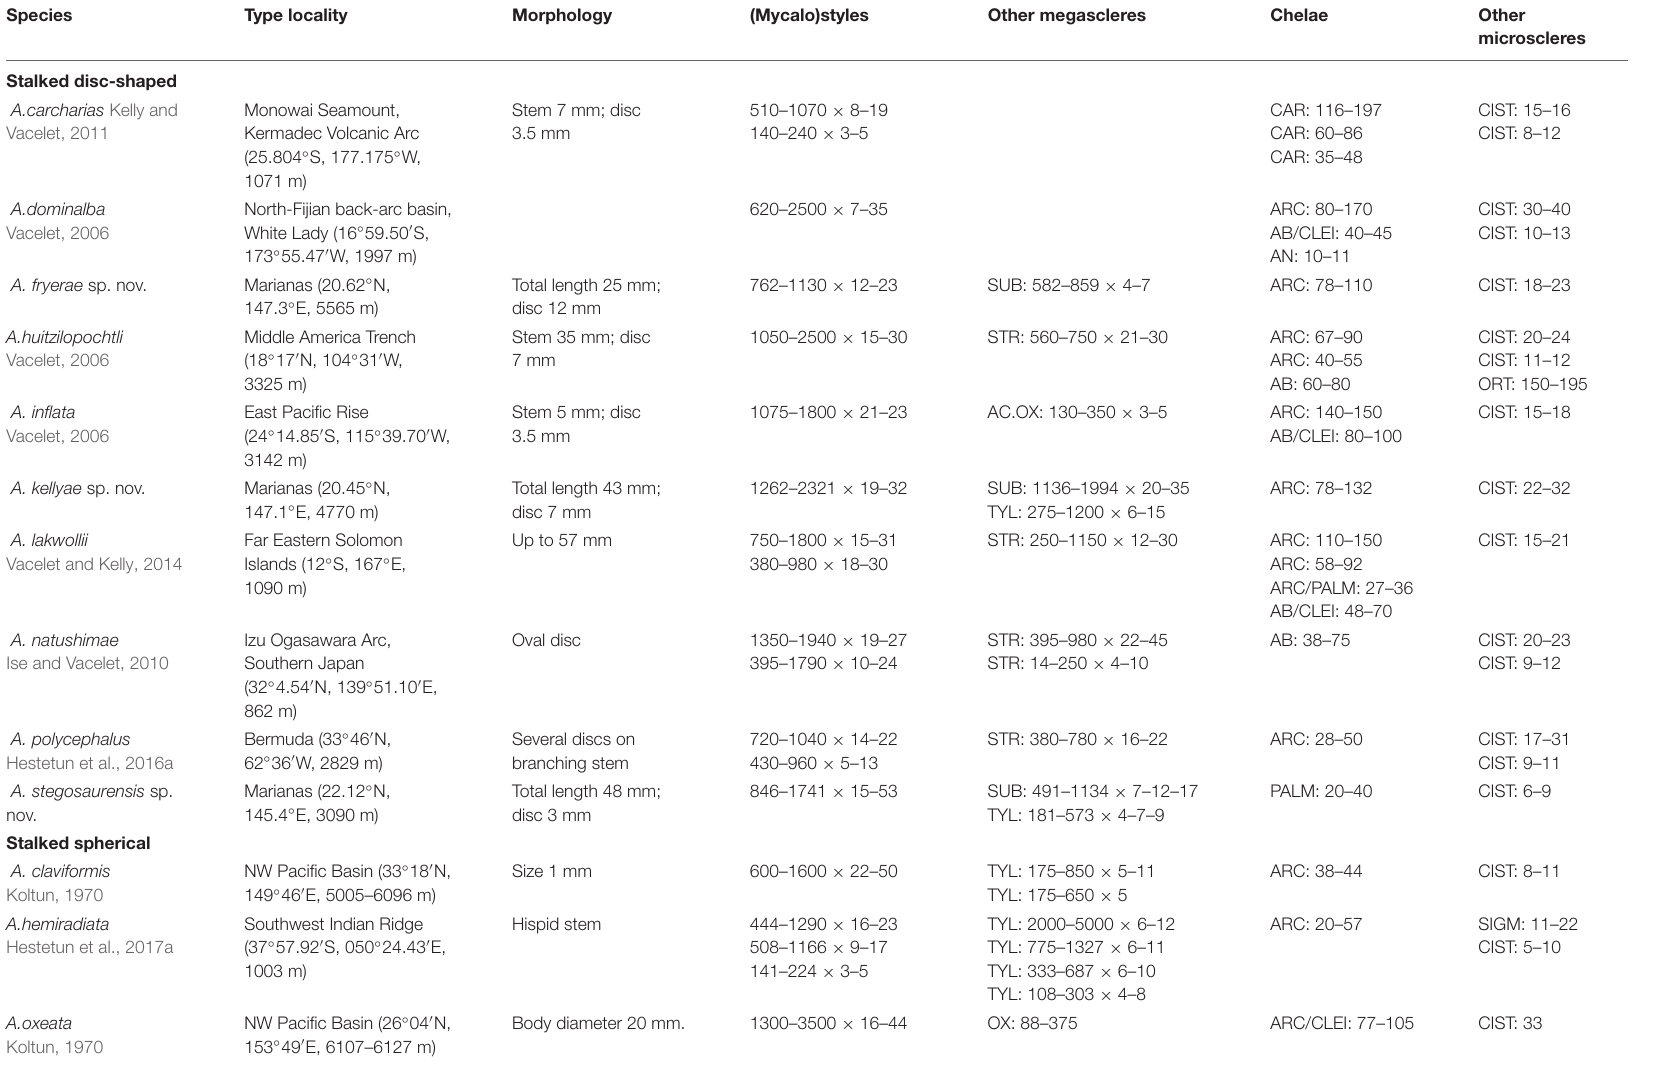
TABLE 2 | Overview of morphological characters and type location for currently known Abyssocladia